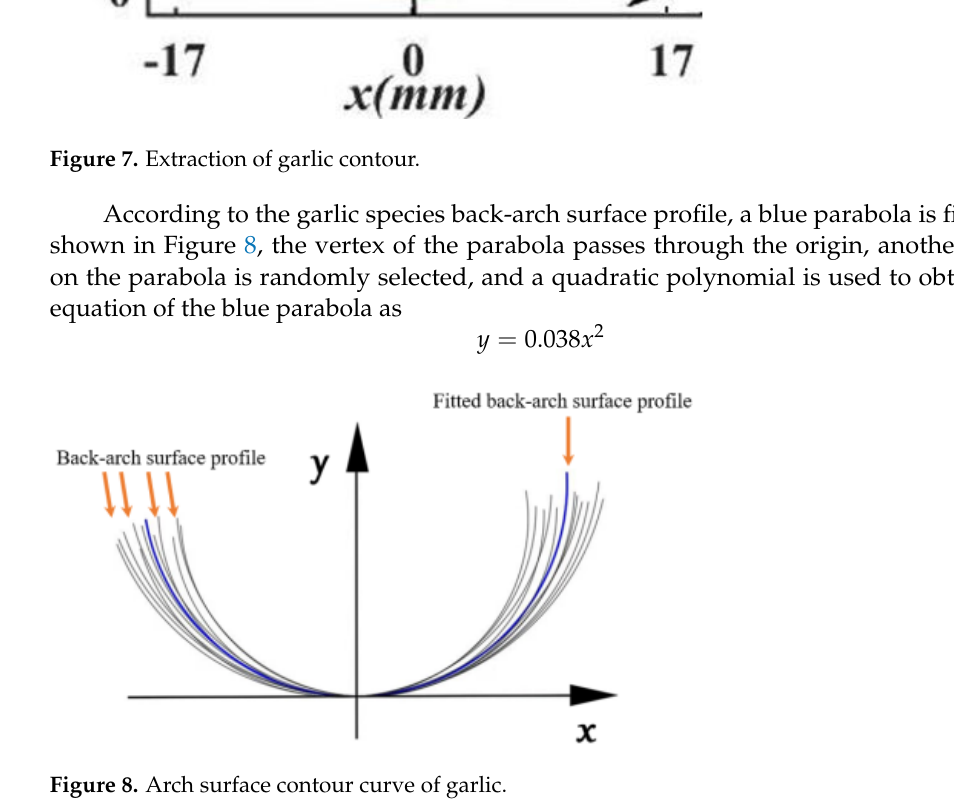
Figure 7. Extraction of garlic contour.